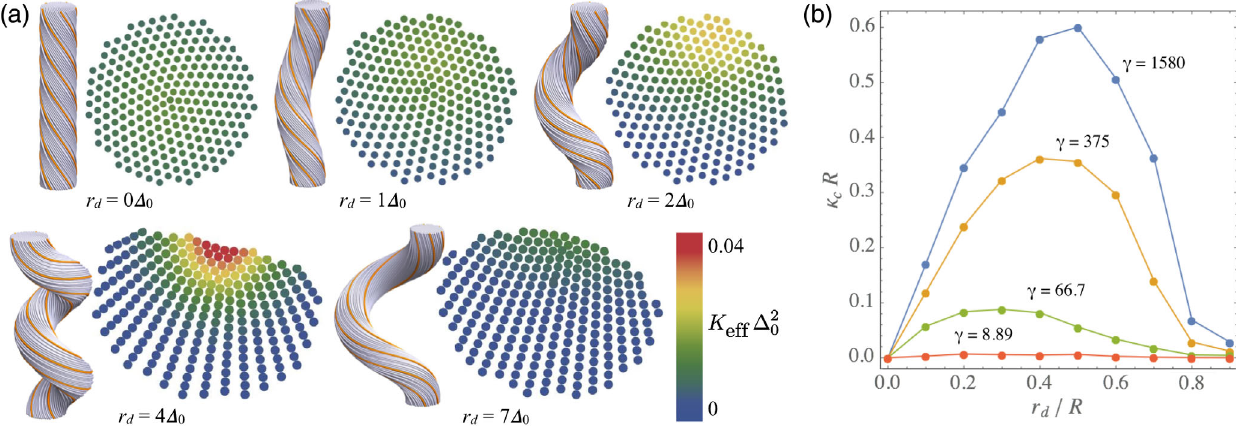
FIG. 12. (a) Visualizations of R= Δ 0 ¼ 10 bundles containing fivefold disclinations displaced off center at a distance r d , and with γ ¼ 1580 . Cross-sectional views show the equivalent Gaussian curvature K a function of the defect ’ s position.